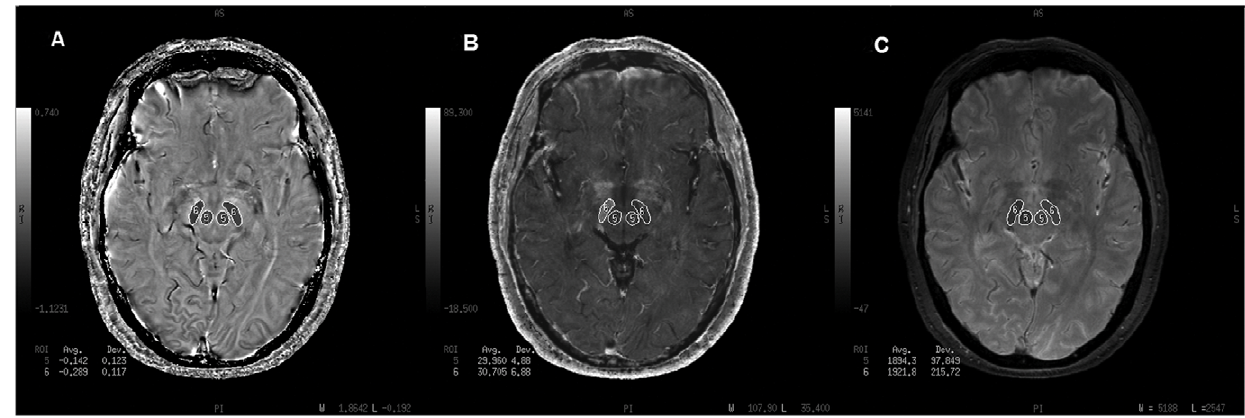
Figure 2. Illustration of the selected regions of interest. (A), The selected ROIs of the corrected phase images. (B), The selected ROIs of the R2* images. (C), The selected ROIs of the magnitude images. 5=red nucleus; 6=substantia nigra.